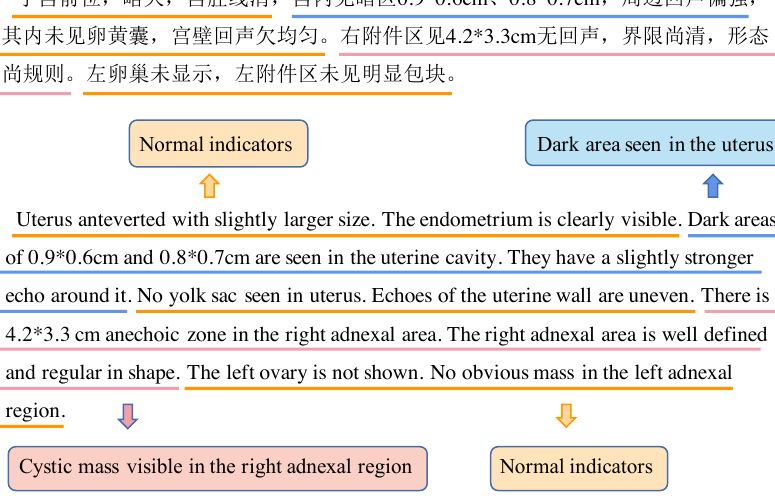
Figure 5. Example of a pair ultrasound description and finding. Table 7. Accuracy, recall and F-score of the five basic model with pattern-matching